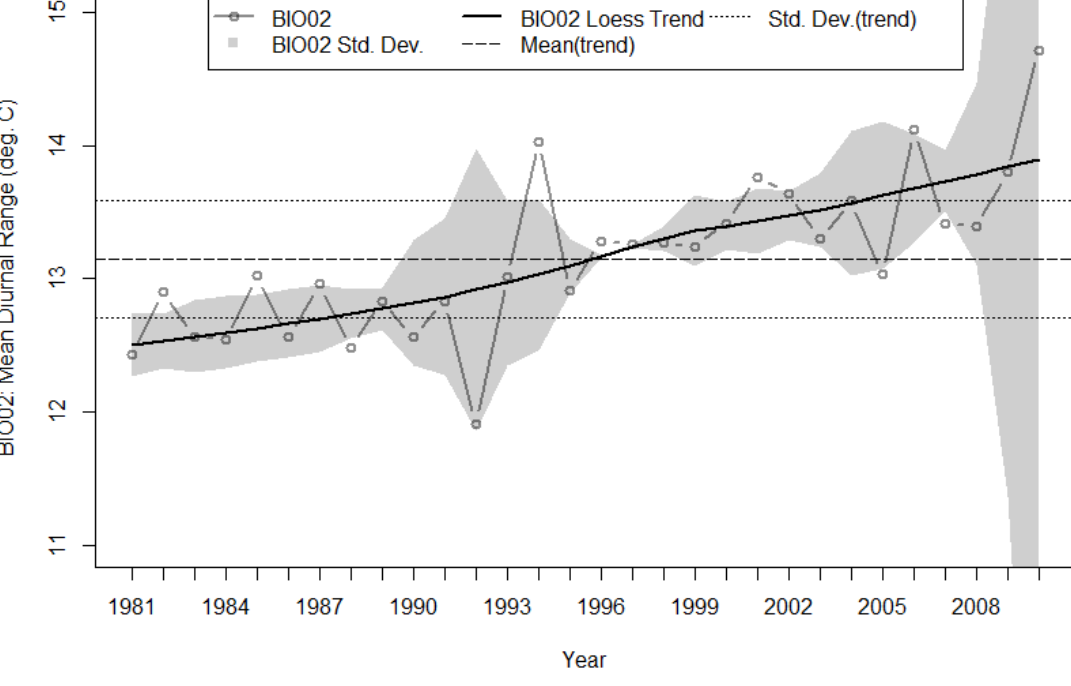
Figure 10. Spatial aggregated monthly time series of mean daily rainfall (mm) across the study area showing the loess trend, mean and standard deviations and the original monthly data, extracted from AWAP [39] for the period